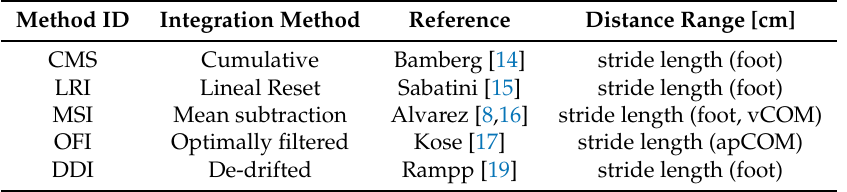
Table 4. Methods for distance estimation and